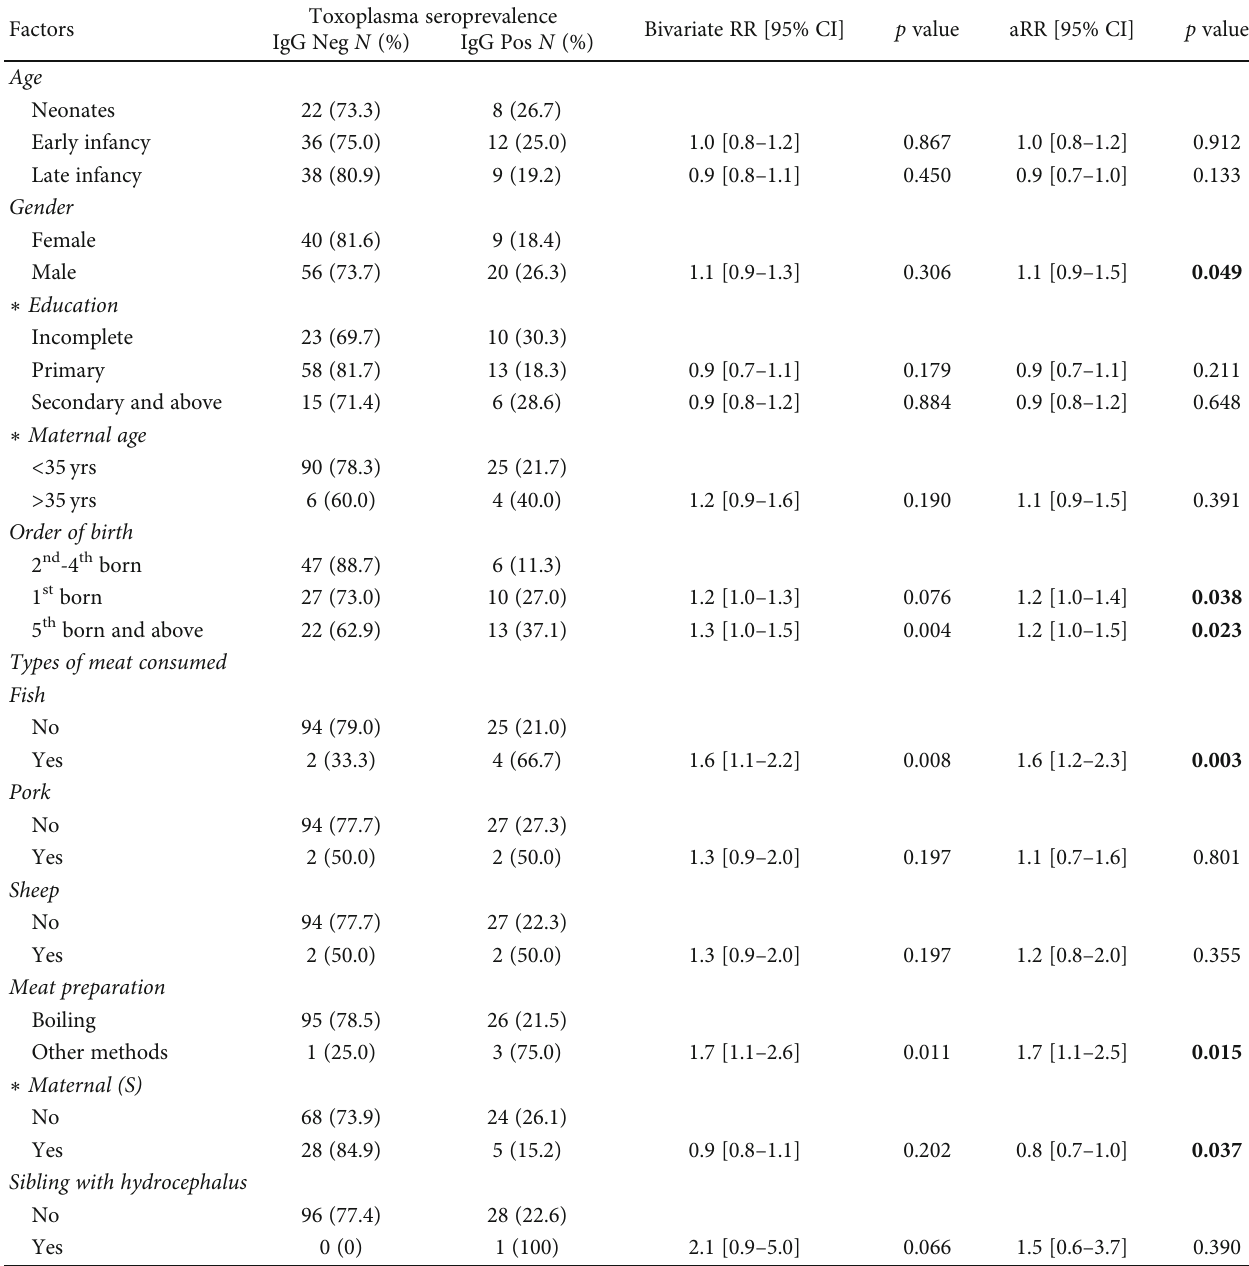
Table 5: Risk factors associated with T. gondii seropositivity among infants with hydrocephalus and their